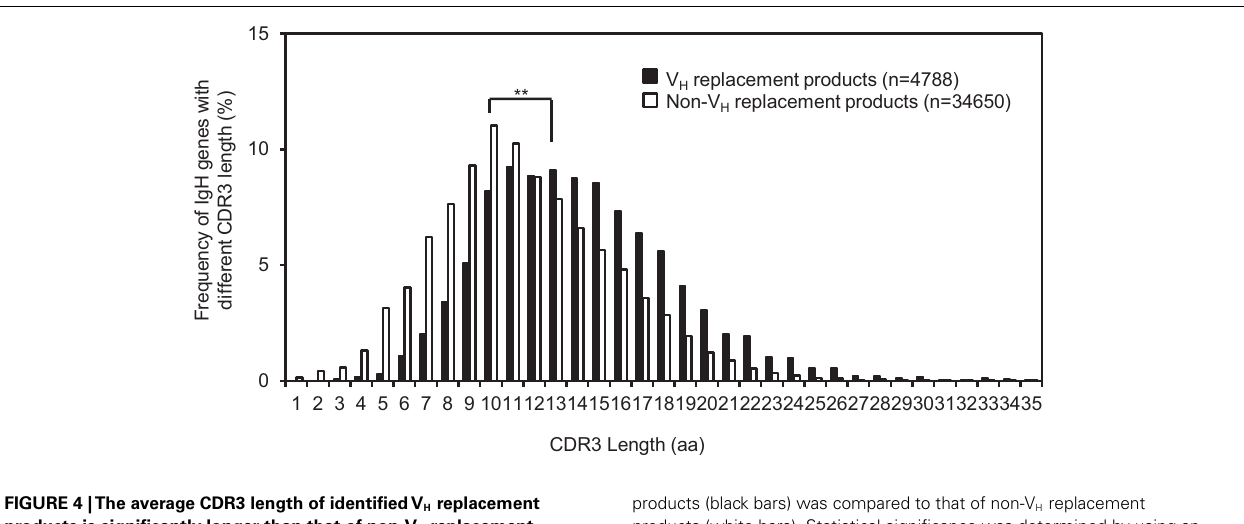
FIGURE 4 |The average CDR3 length of identifiedV H replacement products is significantly longer than that of non-V H replacement products .The distribution of IgH genes with different CDR3 lengths is shown in the bar graph.The average CDR3 length ofV H replacement